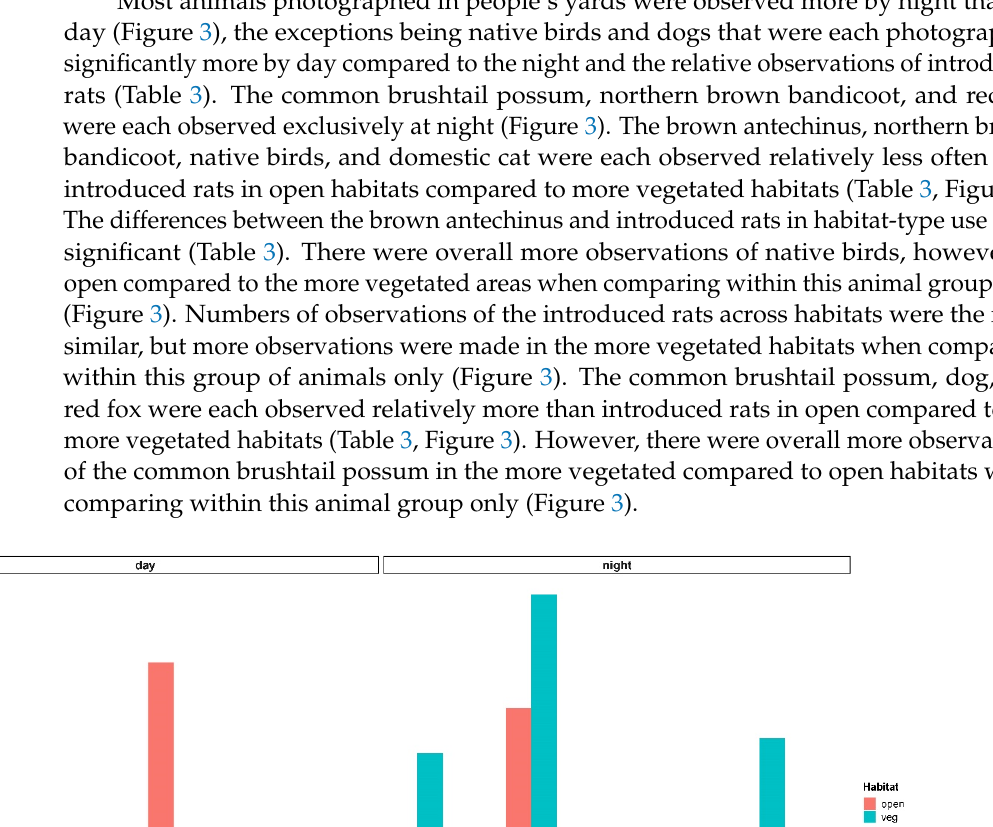
pigeon— Ocyphaps lophotes, laughing kookaburra— Dacelo novaeguineae, Australian magpie— Gymno ‐ rhina tibicen, noisy miner— Manorina melanocephala (all grouped together as ‘native bird’); black rat— Rattus rattus and brown rat— R. norvegicus (grouped together as ‘intro rat’); domestic dog— Canis familiaris (dog); domestic cat— Felis catus (cat); and red fox— Vulpes vulpes (fox).